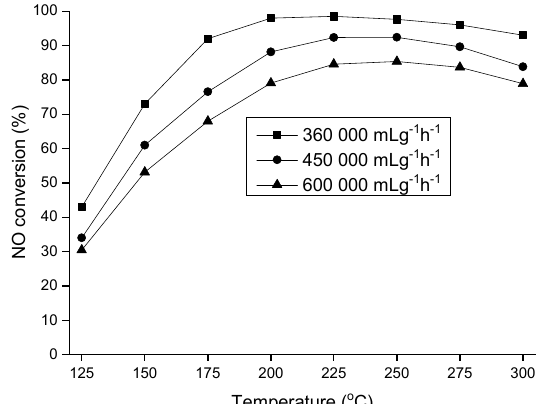
Figure 4. NO conversion profiles of the 25Mn 0.75Ace Fe 0.20Nit Ce 0.05Ace /Ti catalyst at various space velocities.